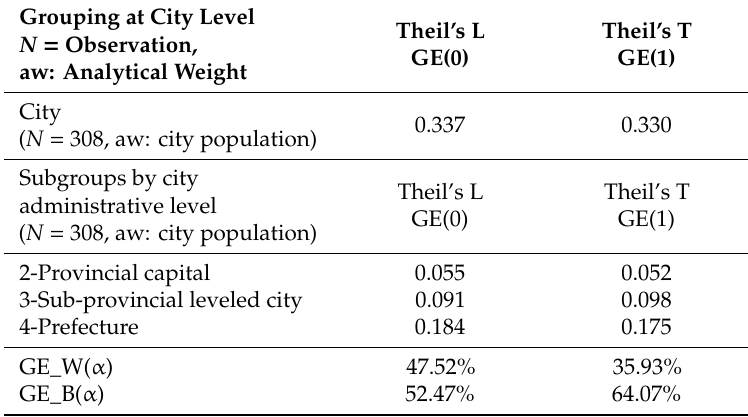
Table 4. Total GE ( α ) Values Based on City’s Average Score Per 10,000 People (at city level).